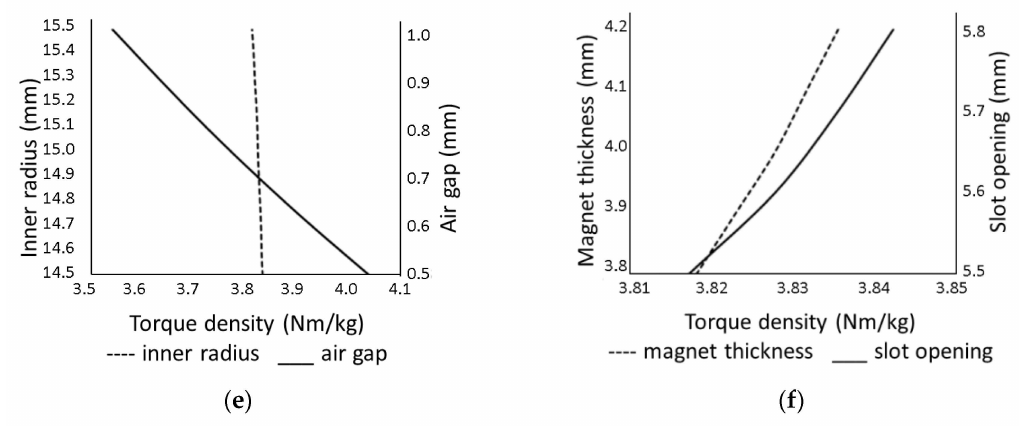
Figure 4. The sensitivity of torque versus : ( a ) the inner radius and air gap; and ( b ) magnet thickness and the slot opening. The sensitivity of torque ripple versus : ( c ) the inner radius and air gap; and ( d ) magnet thickness and the slot opening. The sensitivity of torque density versus : ( e ) the inner radius and air gap; and ( f ) magnet thickness and the slot opening.